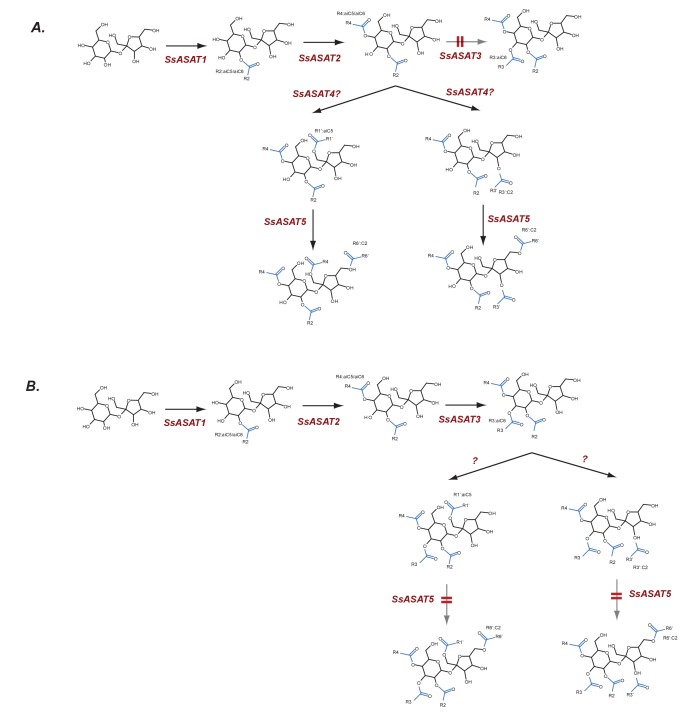
Hypothesized routes of metabolite flow in VIGS knockdown plants.(A) SsASAT3 knockdown and (B) SsASAT5 knockdown. The perturbed pathway steps are denoted by a blurred arrow and two red lines. All acylation positions are hypothesized based on in vitro data and knowledge of the enzyme activities.